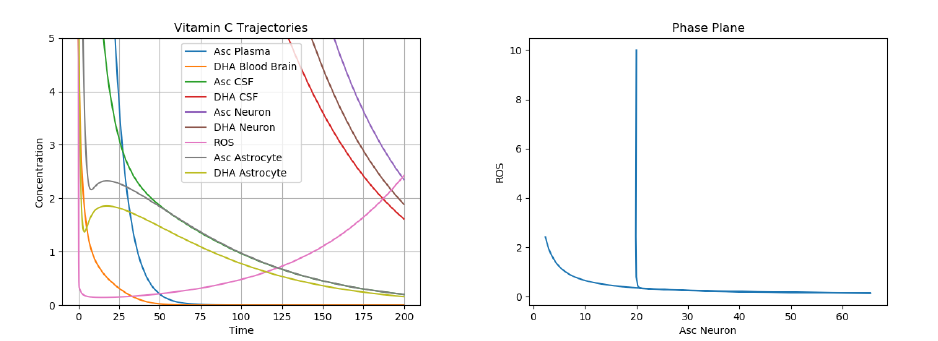
Figure 8. Dynamics of AA, DHA, and ROS in AD with AA Treatment